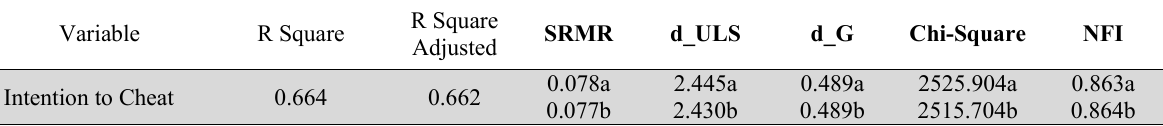
The result of model fit